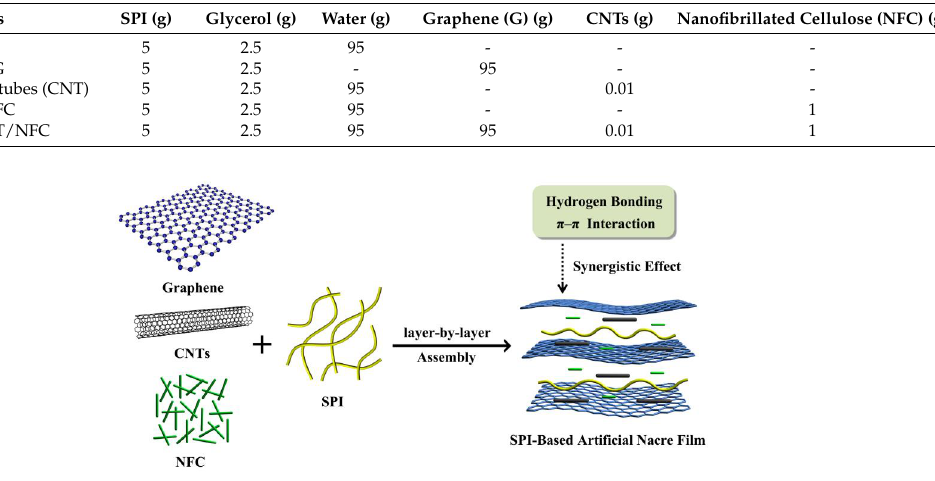
Scheme 1. The schematic diagram of the fabrication procedure for SPI-based artificial nacre